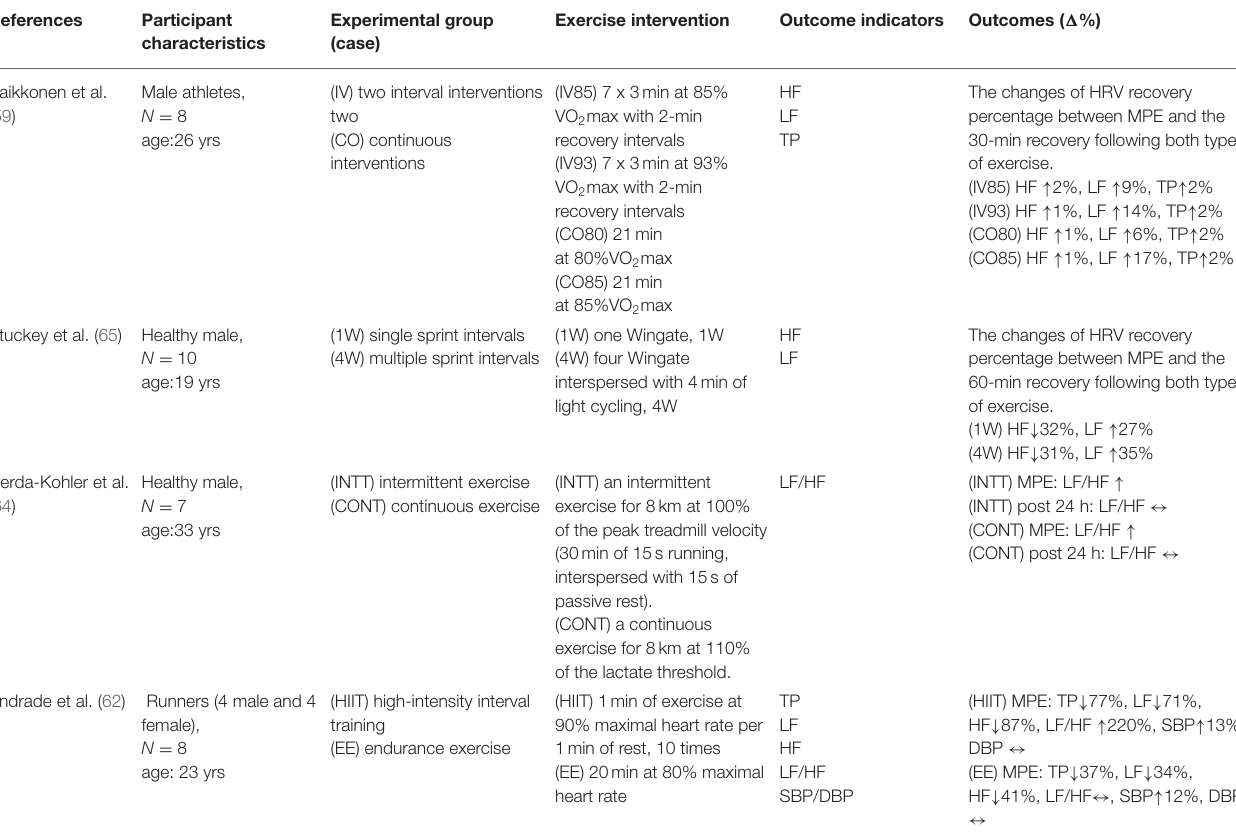
TABLE 1 | Comparison of high-intensity interval exercise and continuous exercise on autonomic nervous system to acute exercise.